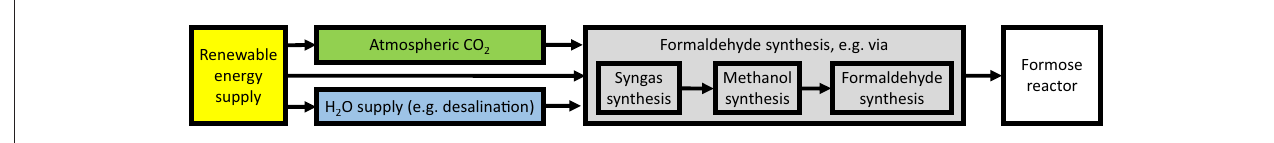
FIGURE 1 | Sketch of the integrated synthesis plant compartments. The only actual input is electric energy and the output are the targeted